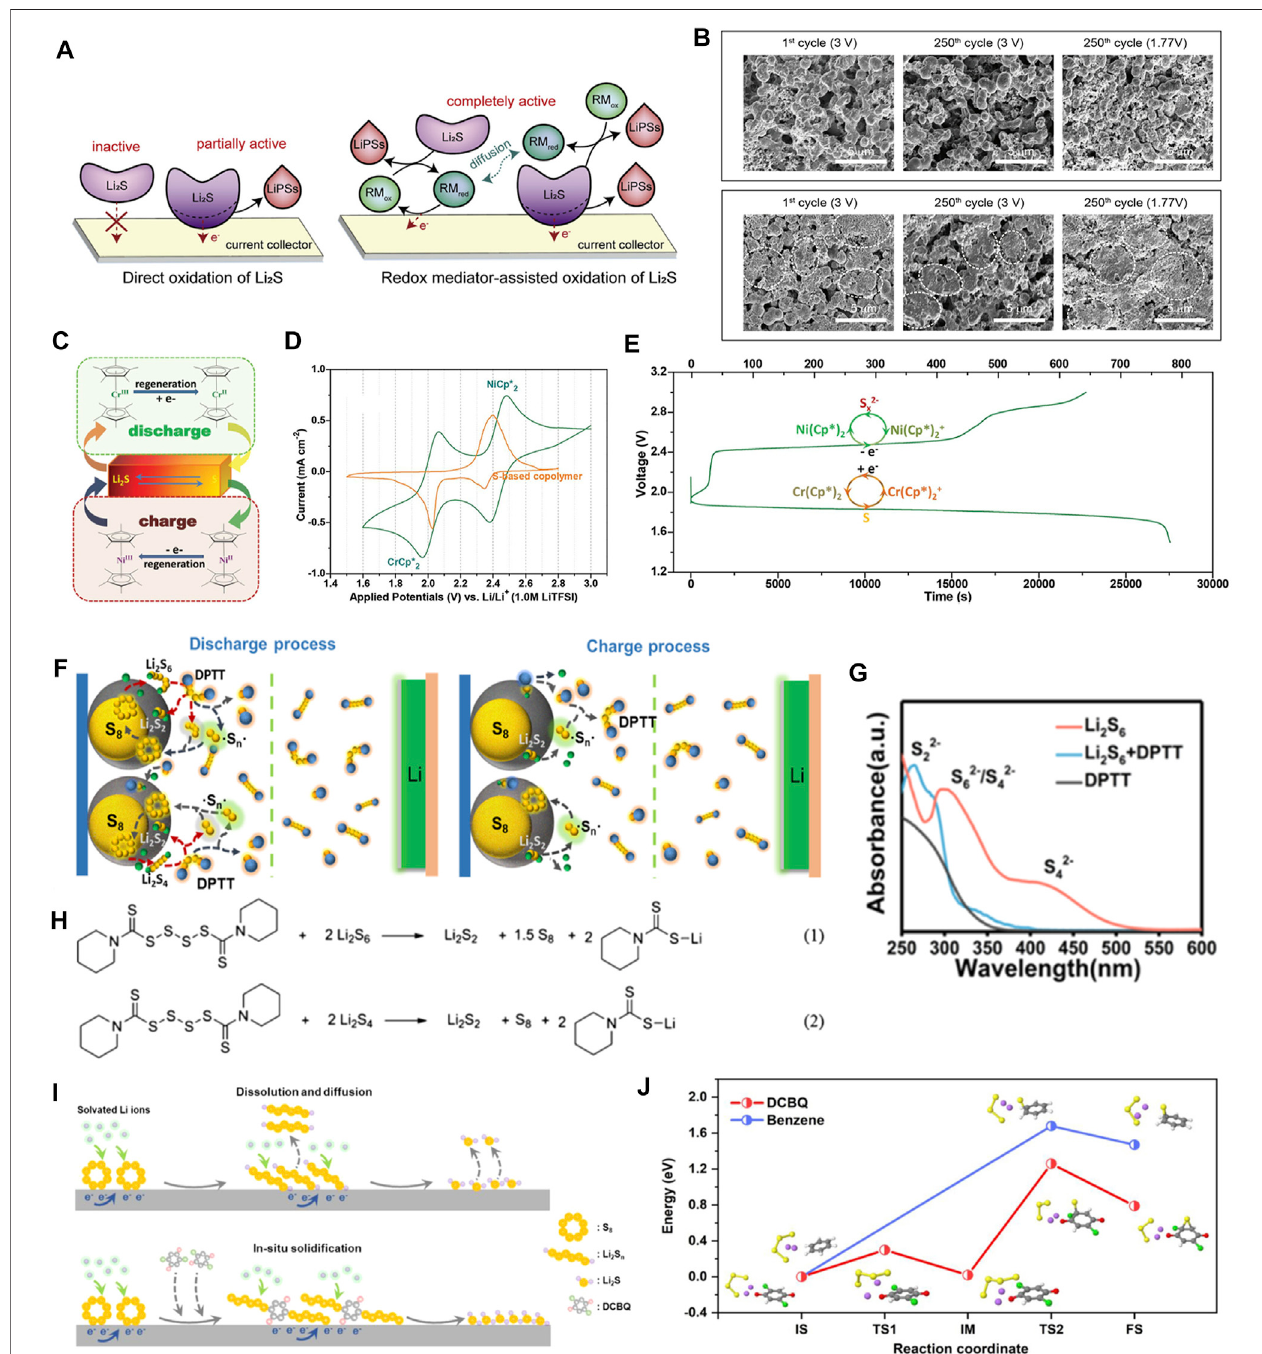
FIGURE 7 | The oxidation processes and speci fi c solid – solid transformations of LiPSs by organic electrocatalytic redox mediators in electrolyte. (A) The comparison ofdirect oxidation and redox mediator-assisted oxidation ofLi 2 Sin Li − Sbatteries. (B) Morphology evolutions ofLi 2 Sprecipitationon thesurface ofcathode with and without AQT additives. (A, B) Figure reproduced from the data in Tsao et al. (2019). (C, D) The schematic illustration of the oxidation – reduction process of Li 2 S catalyzedbyCrCp* 2 andNiCp* 2 andtheircorrespondingCVpro fi les. (E) Thegalvanostaticcharge/dischargecurvesofaLi − SbatteryunderthepresenceofCrCp* 2 and NiCp* 2 . (C – E) Figure reproduced from the data in Li et al. (2015). (F – H) The proposed chemical reaction paths between DPTT and LiPSs. (G) The effect of DPTT mediator by UV-vis absorption spectra. (F – H) Figure reproduced from the data in Xiang et al. (2019). (I) The diagrams of sulfur reduction processes with/without DCBQ additives. (J) Potential energy levels of Li 2 S 4 reduction process under the presence/absence of DCBQ additive. (I, J) Figure reproduced from the data in Chen et al.